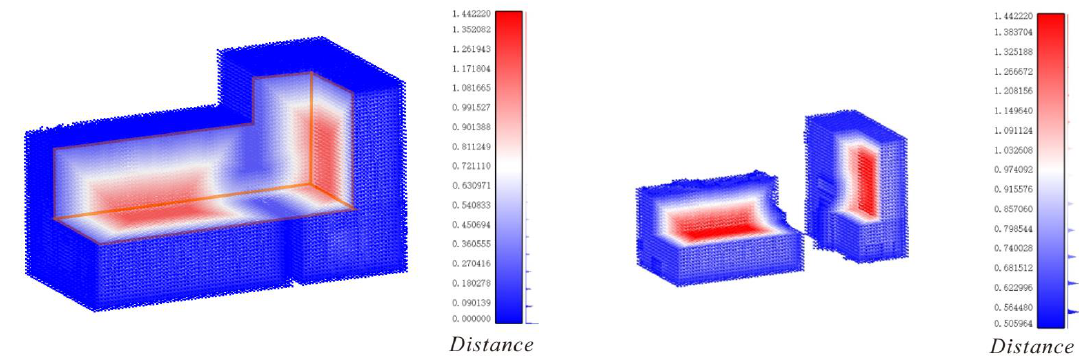
Figure 6. Visualizations of the EDT and a distance map obtained using a threshold.